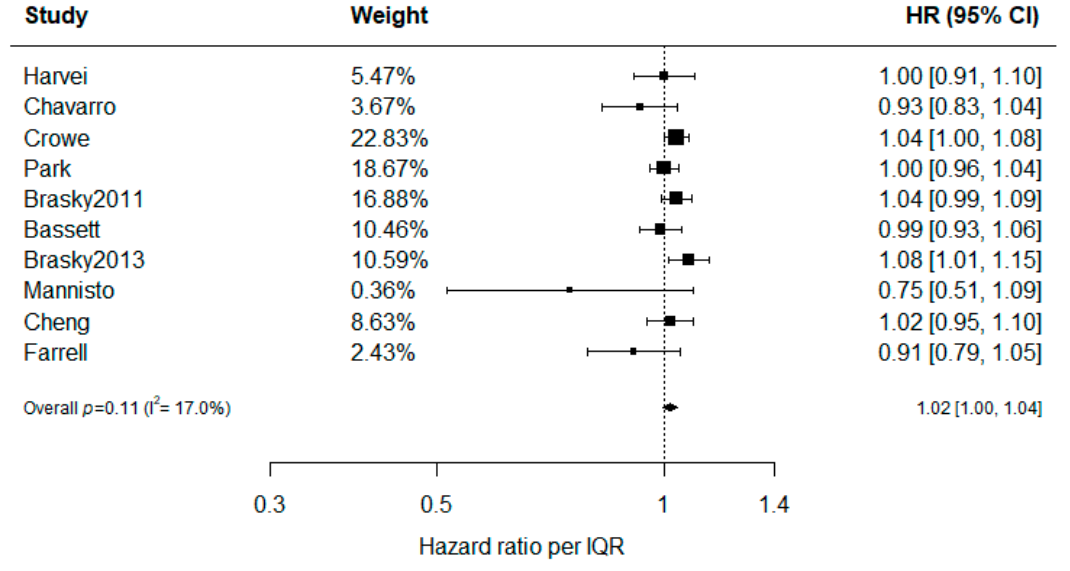
Figure 1. Hazard ratios with 95% CIs are presented by cohort to predict the risk of PC by EPA (Figure 1a) and, separately, DHA (Figure 1b). Neither EPA ( p = 0.20) nor DHA ( p = 0.11) shows evidence of association with PC risk, with little evidence of study-to-study heterogeneity in risk estimates. All data (except Farrell which are the present results) were taken from Fu et al. [13] where citations to the original studies may be